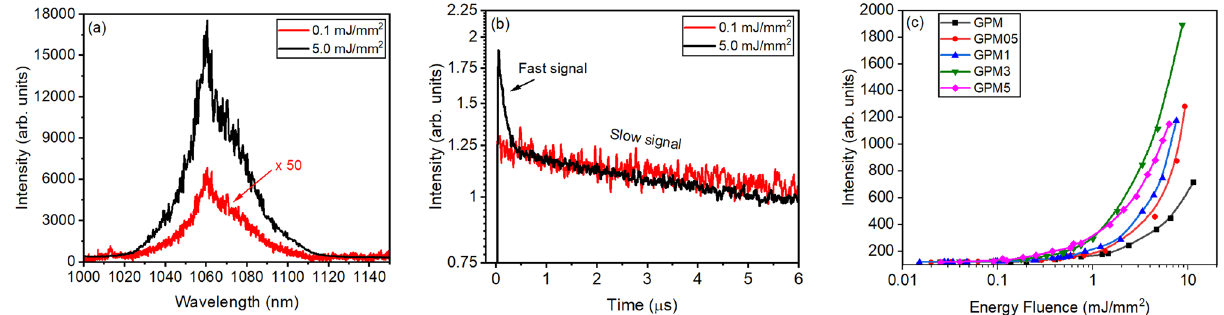
Figure 10. ( a ) Emission spectrum and ( b ) temporal behavior of the signal (at ~ 1068 nm) for the GPM5 sample for EFE below and above EFE th . ( c ) PL intensity vs EFE for all